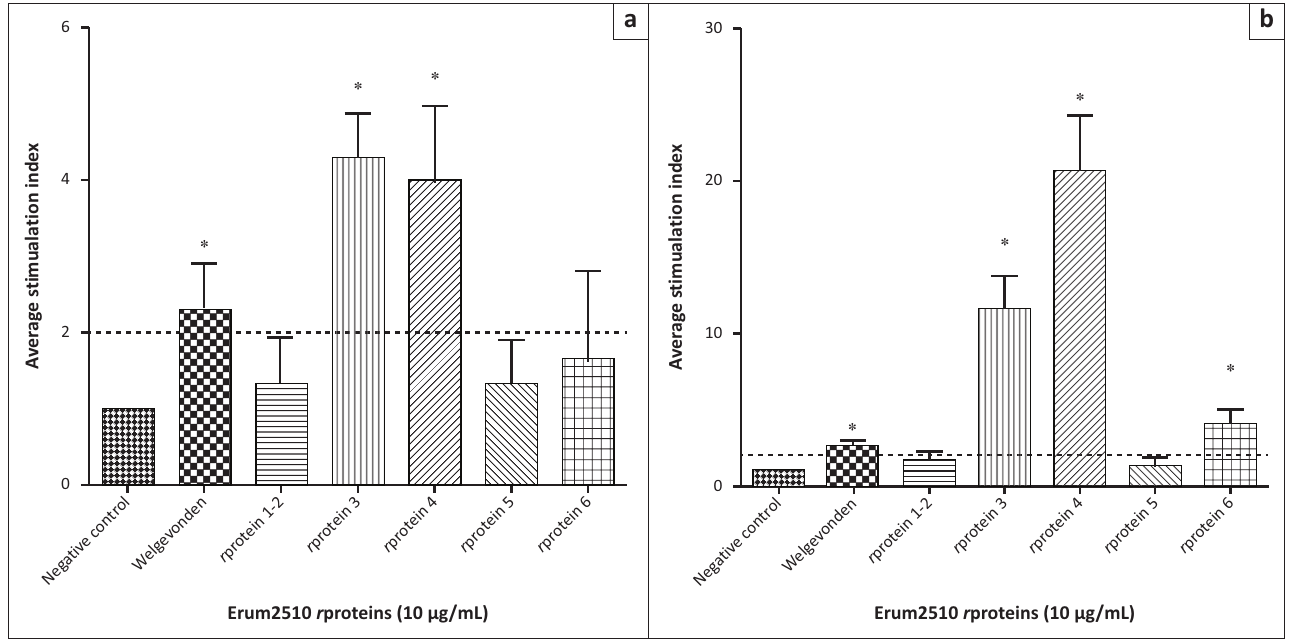
FIGURE 3-A1: Average stimulation index (SI) indicating proliferative response of immune peripheral blood mononuclear cells isolated from sM2 (a) and s6823 (b) to five Erum2510 sub-rproteins. Crude Welgevonden strain antigen was included as a positive control and unstimulated peripheral blood mononuclear cells as negative control. Horizontal dashed line represents a stimulation index of 2, which is the cut-off point for a positive response.